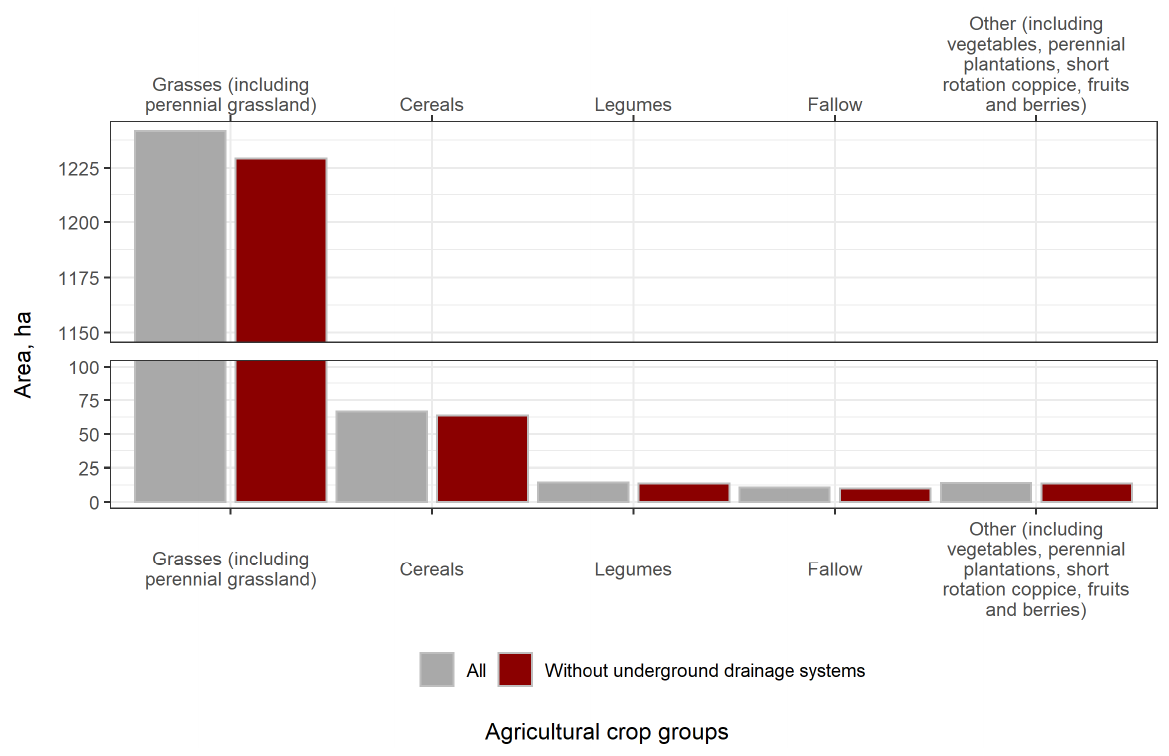
Figure 8. Area of low ‐ value agricultural land parcels suitable for agroforestry by groups of currently cultivated agricultural crops (declared under the Rural Support Service). cultivated agricultural crops (declared under the Rural Support